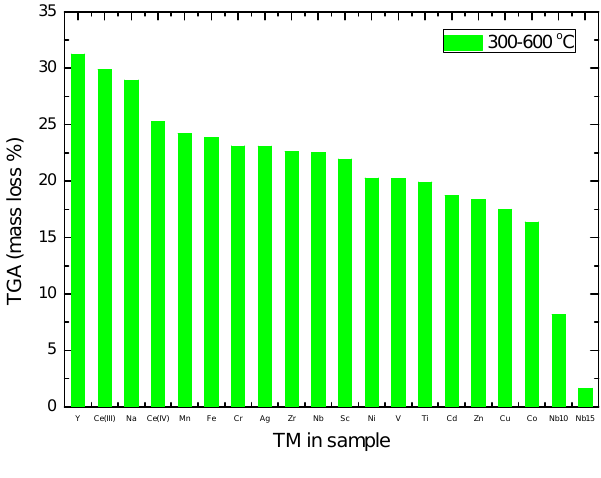
Figure 5. TGA data showing the mass loss between 300 and 600 ◦ C for the samples with additive.